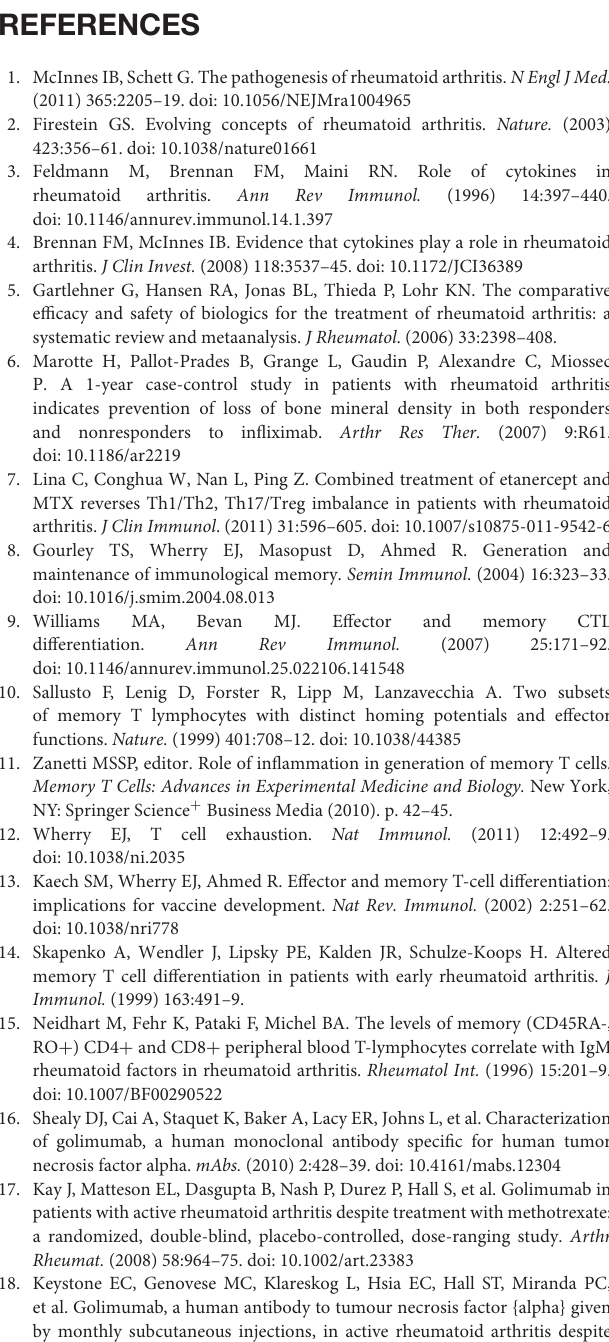
Supplementary Figure 2 | Statistical analysis of IFN γ , TNF α , IL-2, and IL-17 secreting CD8T cells from: T N , T CM . T EM, and T E subsets in GM untreated patients ( n = 15), GM treated patients ( n = 14) and control individuals ( n = 28). Supplementary Figure 3 | Statistical analysis of IFN γ , TNF α , IL-2, and IL-17 secreting CD4T cells from: T N , T CM . T EM, and T E subsets in GM untreated patients ( n = 15), GM treated patients ( n = 14) and control individuals ( n = 28).